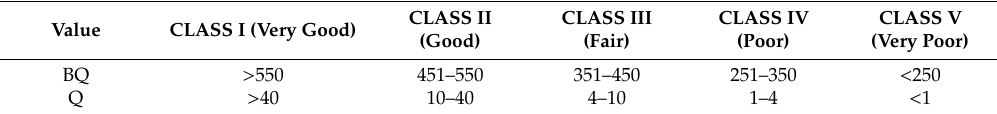
Table 1. Relationship between the basic quality classification system (BQ system) and the quality system (Q system).